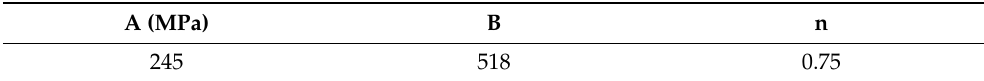
Table 2. Estimation of DC01 constants A, B, and n.